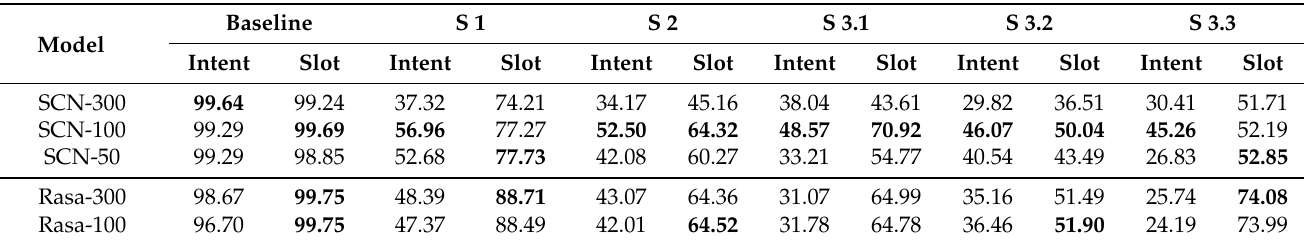
Table 2. F1-scores obtained by the S EM C APS N ET and Rasa models using different word embedding models (best results are in